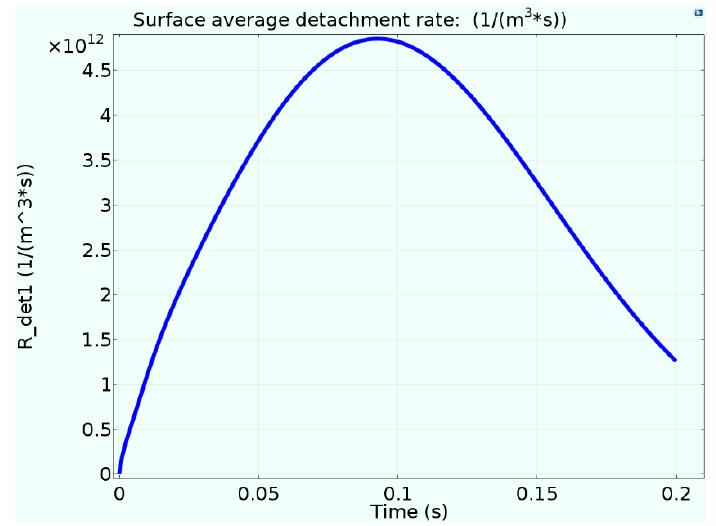
Figure 12. Time dependence of the average detachment reaction in the discharge space.